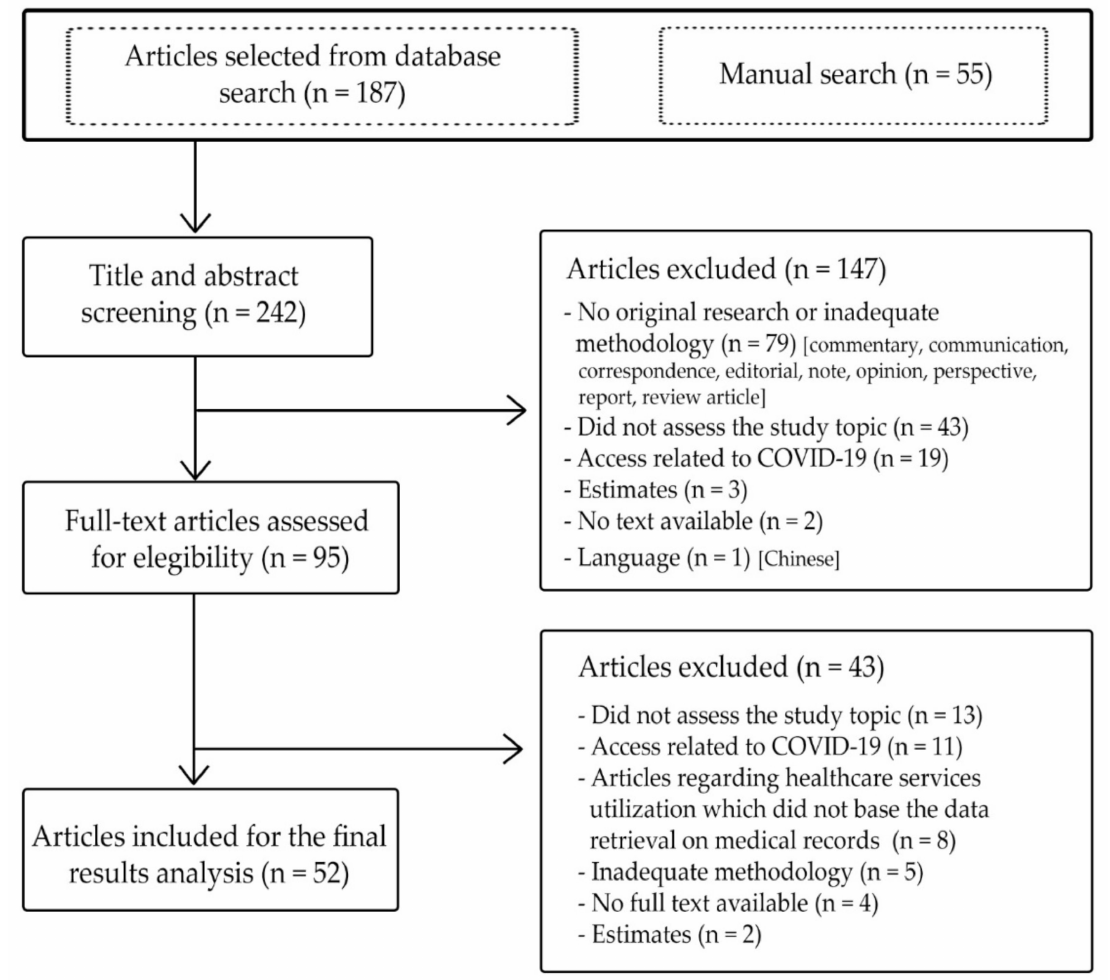
Figure 1. Flow chart of study selection